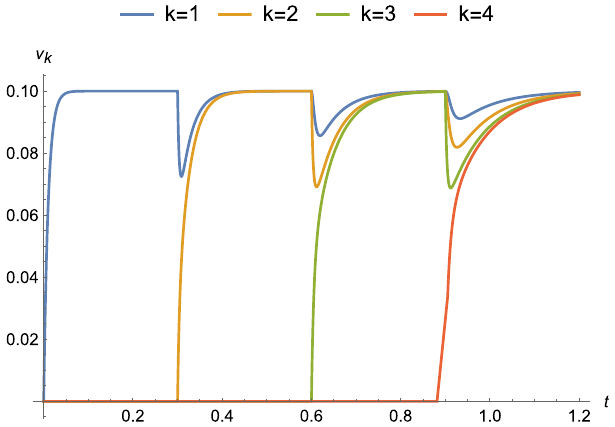
Figure 10. Complete response for parameters that approximate an axon ( α = 10 − 6 , R = 10 12 � , C = 10 − 8 F , and | ν 0 | = 100 mV ) under a binding regime that approximates diffusion-limited growth with a time between attachments of T = 0.3 s.